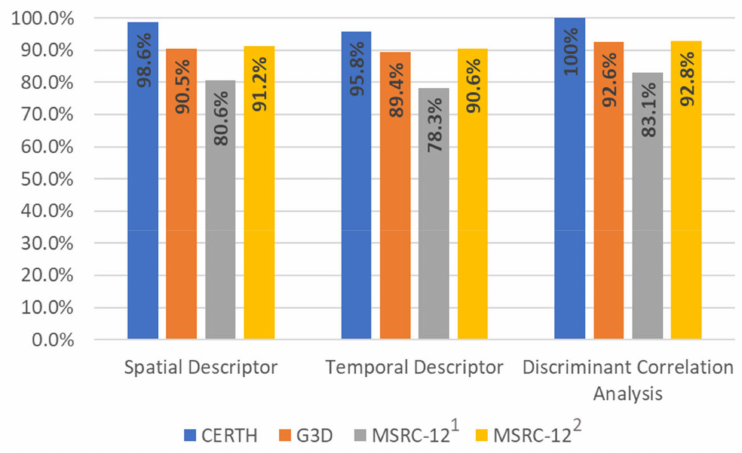
Figure 5. Contribution of different feature representations and fusion results through discriminant correlation analysis for CERTH, G3D, and MSRC-12 databases. 1 37% of the MSRC-12 dataset was used for training and 63% for testing. 2 “Leave-persons out” protocol was